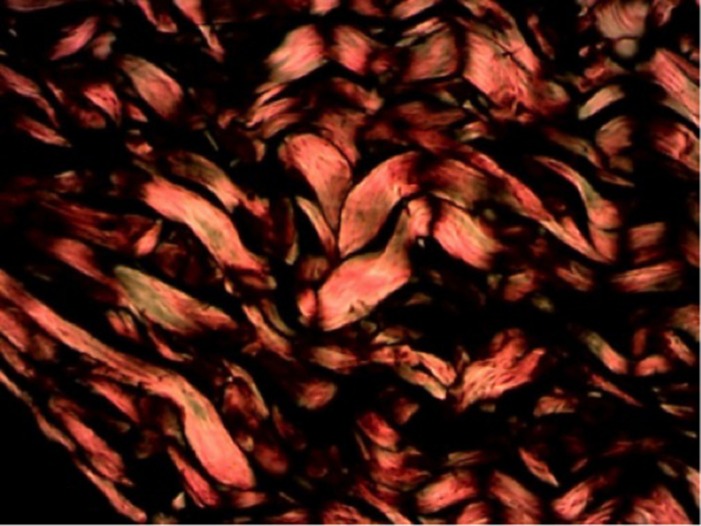
Picrosirius staining for experimental group/14 day subset.